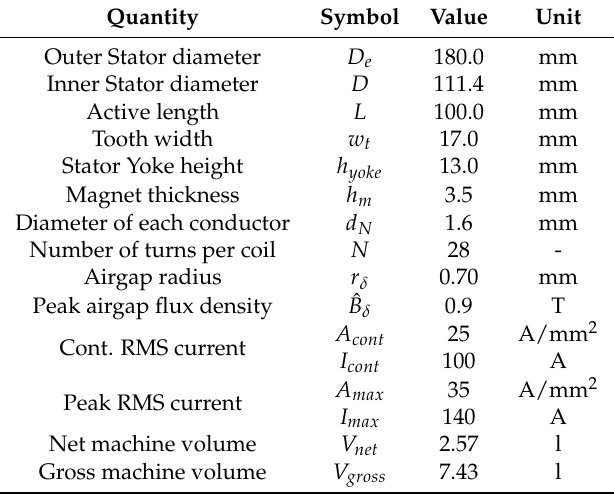
Figure 3. Details of lamination geometry, cooling channels and conductor disposition. ( a ) Stator and rotor laminations geometry, coil disposition and cooling channels; ( b ) The arrangement of copper conductors, potting material and oil cooling channel within one slot. Table 3. Resulting geometry and loading data from the machine dimensioning